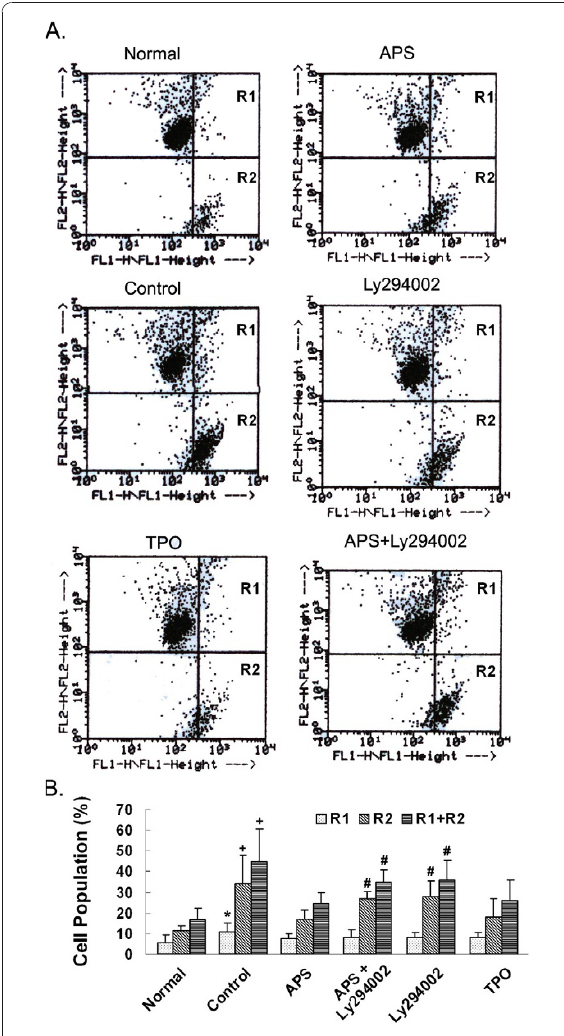
Figure 7 Effects of APS on apoptosis analyzed by JC1 assay . M-07e cells were treated as described above, incubated with JC-1 reagent and then subjected to flow cytometry analyses. (A). Dot plots of Normal, APS-treated, Control, Ly294002-treated, TPO-treated, and APS+Ly294002-treated samples. (B). Quantification and statistical analyses of treatment effects. Percentages of R1 (transitional cell subset containing both JC1 aggregates and monomers, representing early apoptotic cells), R2 (apoptotic cells containing mostly monomers, representing late apoptotic cells), R1+R2 (total apoptotic cells) cells are shown. Statistical tests were carried out between the control/treated samples and the corresponding normal samples respectively.*: p < 0.05; #: p < 0.01 and +: p < 0.001.